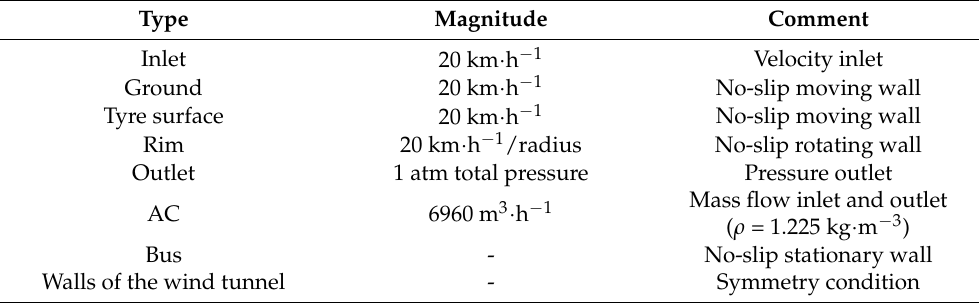
Table 3. Boundary